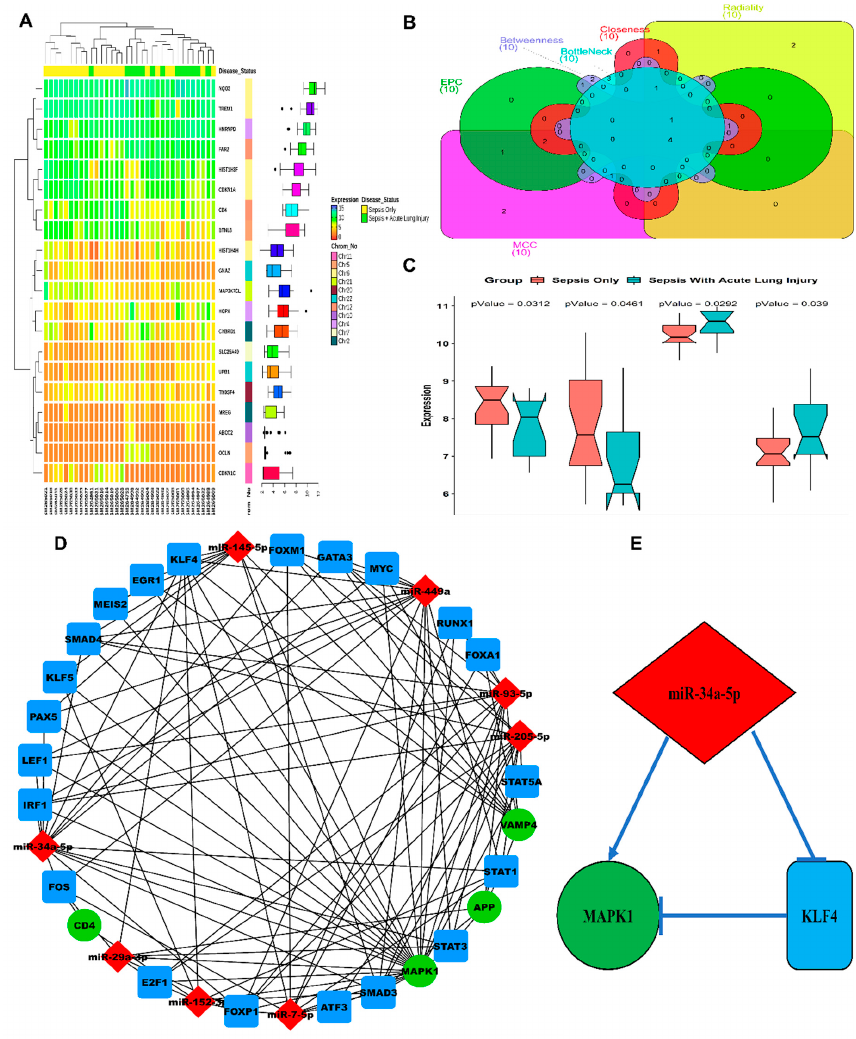
Figure 1. In silico analysis of di ff erentially expressed genes (DEGs) and miRNAs in acute lung injury patients. ( A ) Heatmap plot of top 10 up and down-regulated DEGs. The expression values for each DEG (row) are normalized across all the samples (columns). Hierarchical clustering using Pearson metric and complete linkage method were used for categorizing the data into two disease status groups, i.e., sepsis only and sepsis with acute lung injury. Cluster dendrograms for row and column are displayed along the left and the top sides of the plot. The location of each DEG on its respective chromosome is shown in the right as the row annotation bar. The boxplots in the right panel display the expression data distribution density of each DEG. The line inside each boxplot represents the median, whereas the endpoints of the axis are labelled by minimum and maximum values. ( B) Venn plot for identifying the significant hub genes from the protein–protein interaction (PPI) network. Areas with varying colours correspond to di ff erent centralities (maximal clique centrality, i.e., MCC, edge percolated component, i.e., EPC, closeness, betweenness, bottleneck, and radiality). Top 10 ranked PPI DEGs based on each of the six centrality measures are shown in the Venn plot by di ff erent gene set colours, and their intersectional area reveals the four hub genes. ( C ) Notched boxplots comparing the relative expression levels of our hub genes ( App , Cd4 , Mapk1 , Vamp4 ) in two di ff erent groups, i.e., sepsis only and sepsis with acute lung injury. Significance for aggregated expression values was determined by the Wilcoxon p -values. The notches signify a 95% confidence interval for medians. ( D ) Graphical plot of a three-node miRNA feed-forward loop (FFL) regulatory network. The nodes in green signify our hub genes, nodes in red and blue signifiy the acute lung injury (ALI) / acute respiratory distress syndrome (ARDS)-linked miRNAs and transcription factors (TFs), respectively. ( E ) The higher-order subnetwork comprising one miRNA (miR-34a-5p), TF (Klf4), and our hub gene ( Mapk1 ) along with their relative regulatory interaction